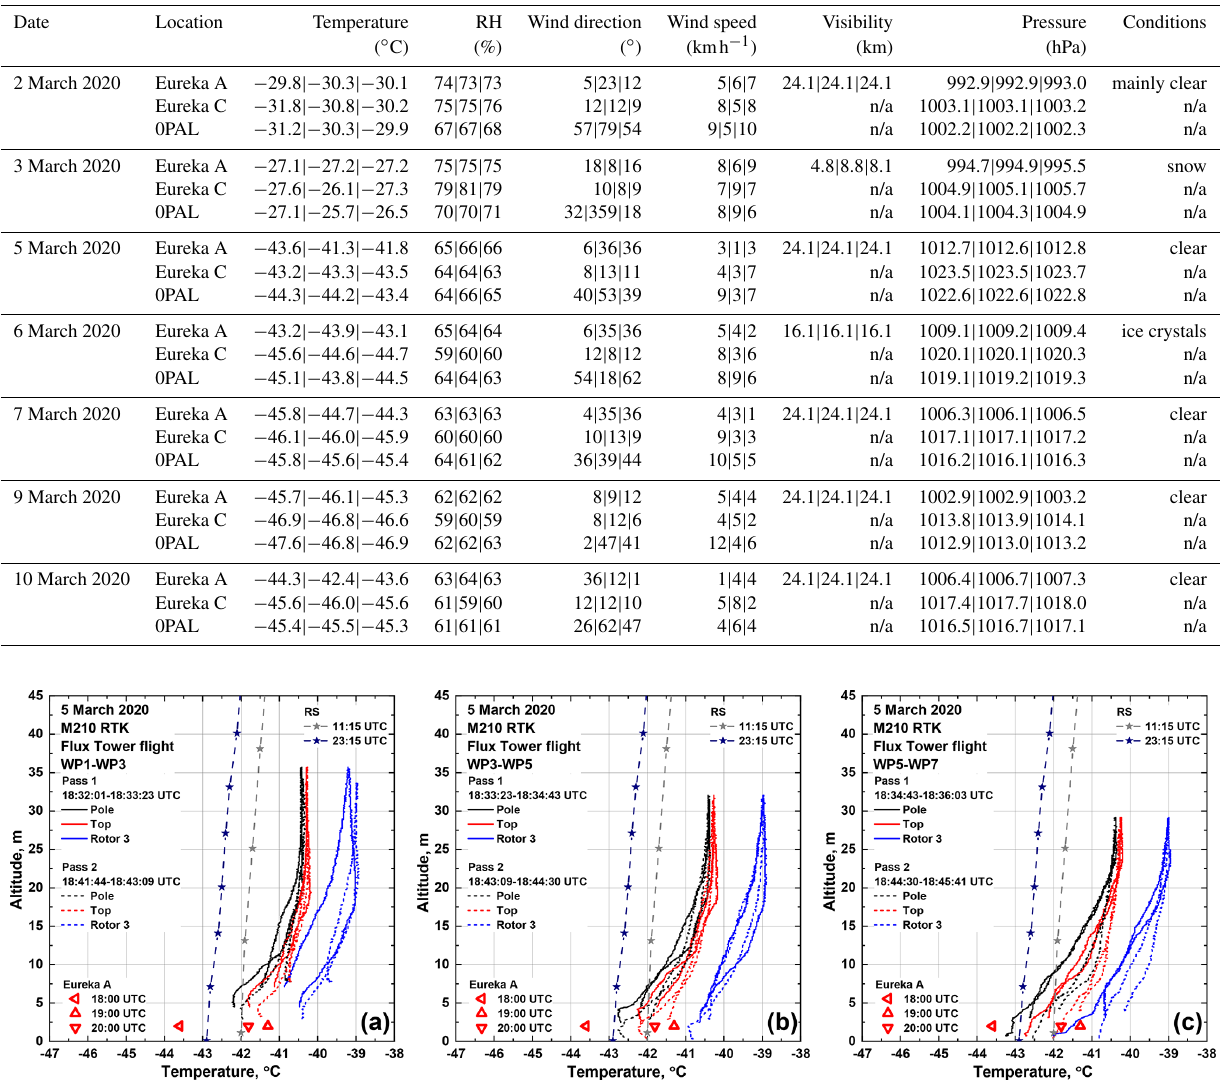
Figure 8. Temperature profiles measured during the M210 RTK two-pass flux tower flight along WP1–WP7 waypoints (see Fig. 7) on 5 March 2020 featuring biases between RTDs attached to different locations (colour-coded) on the airframe and SBI temporal and spatial variability: (a) WP1–WP3, (b) WP3–WP5, (c) WP5–WP7 (see Fig. 7 for the locations of the temperature